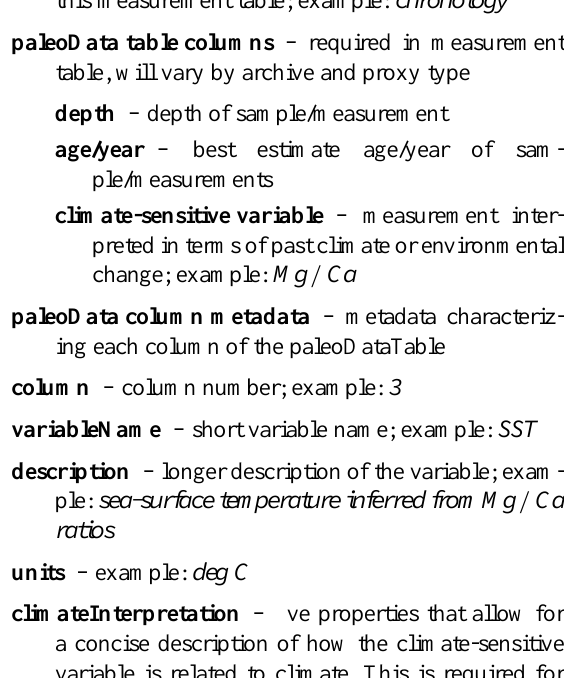
coordinates – longitude, latitude, and elevation, in units of decimal degrees and meters above sea